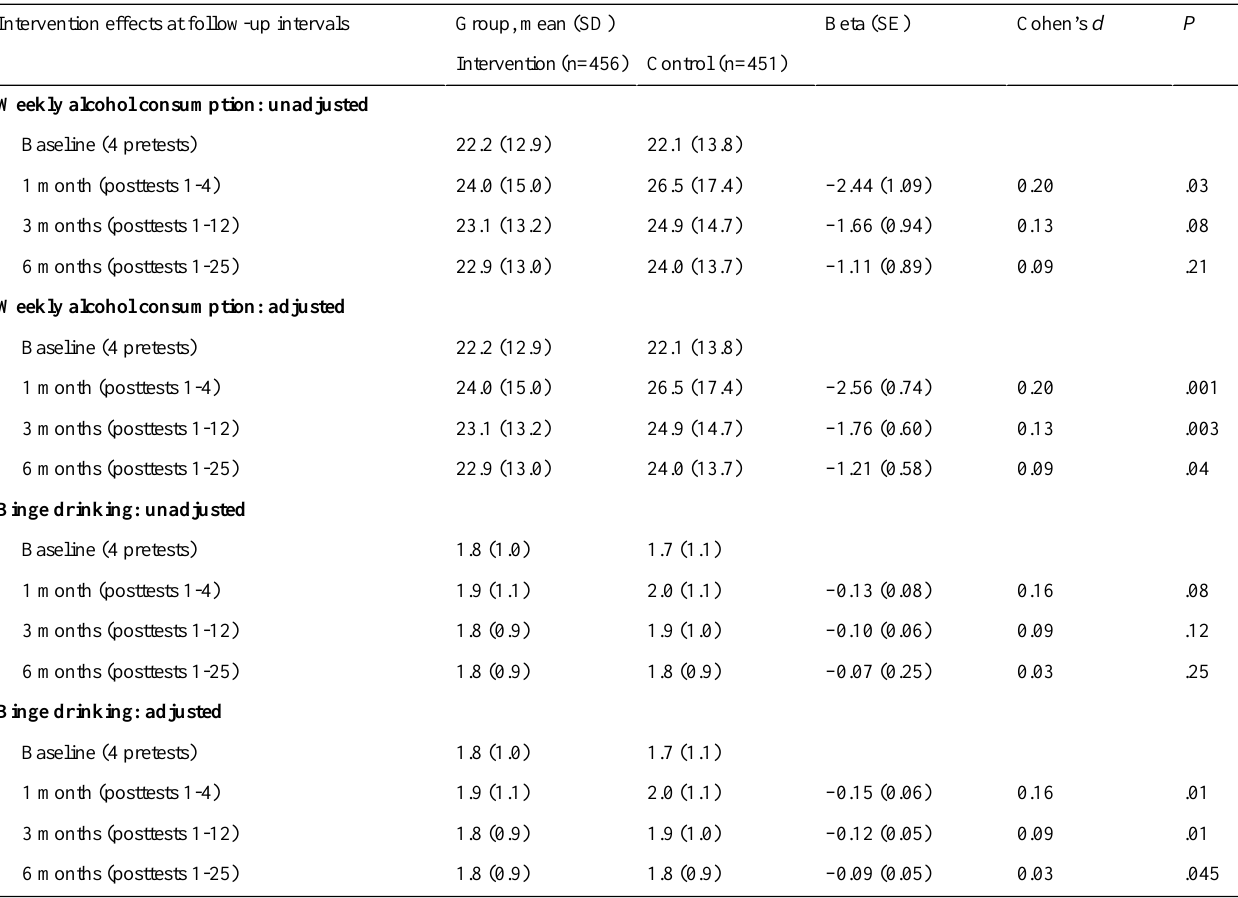
Table 3. Intervention effects of alcohol use at 1-, 3-, and 6-month follow-ups by condition (intervention vs control): linear regression analyses unadjusted and adjusted for the outcome measures at baseline assessment